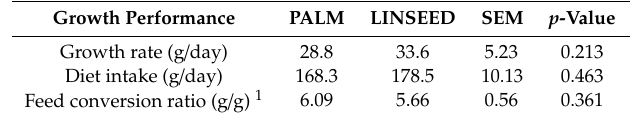
Table 3. Growth performance from di ff erent experimental groups (average).